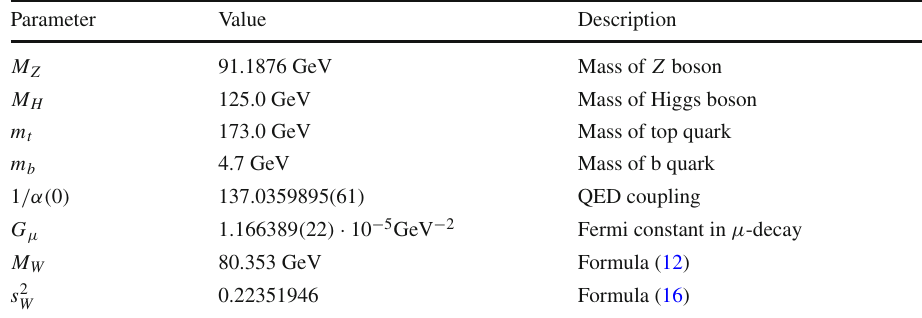
Table 1 The Dizet initialization: masses and couplings. The calculated M W and s 2 are shown W